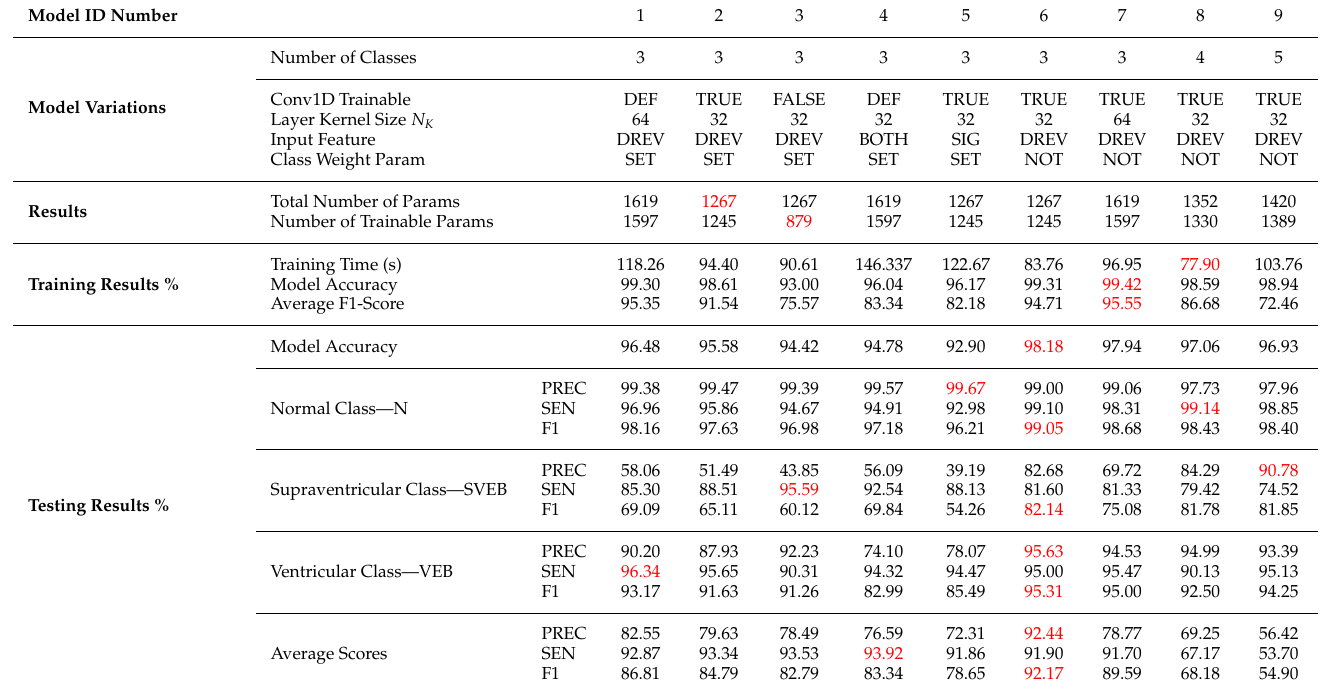
Table 4. Cloud training and testing classification results: accuracy (ACC), precision (PREC), sensitivity (SEN), and F1 score metrics (%) of the proposed model variants. Model variations include: the